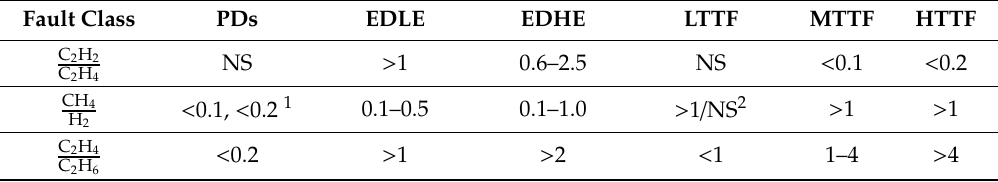
Table 2. IEC60599 DGA fault diagnostic criteria